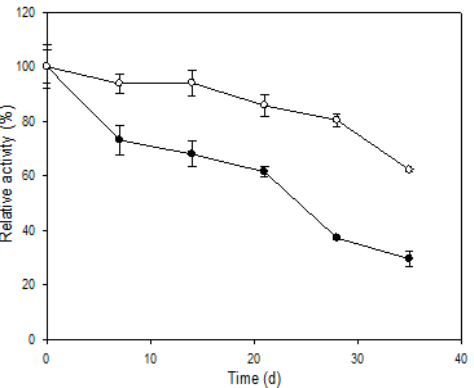
Figure 6. Storage stability at 25 °C. Initial activities were defined as 100%. Solid circle: R5-SazCA; open circle: R5-SazCA-SP. The residual activity was monitored weekly using the CO 2 hydratase activity assay.